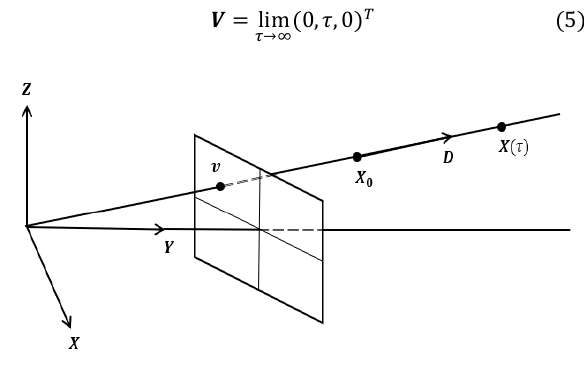
Figure 4 . Definition of the vanishing point